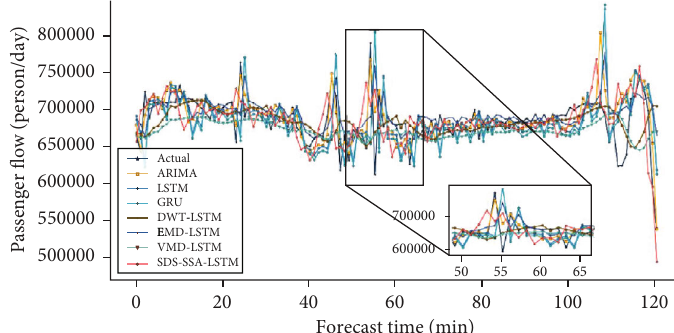
Figure 7: Prediction results of sequence data 1.